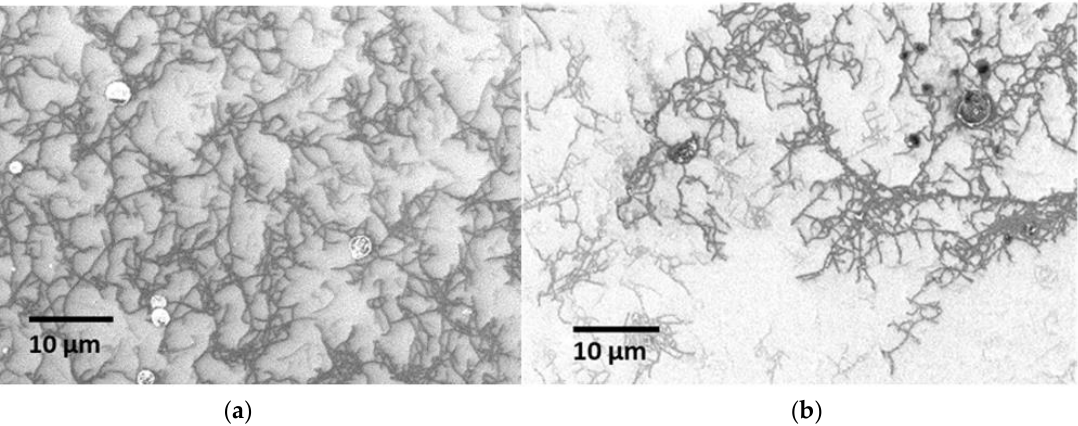
Figure 2. Surface morphology of DIPS SWCNT thin film using FESEM at 1000X with substrate–nozzle distance at: ( a ) 10 mm; ( b ) 4 mm.